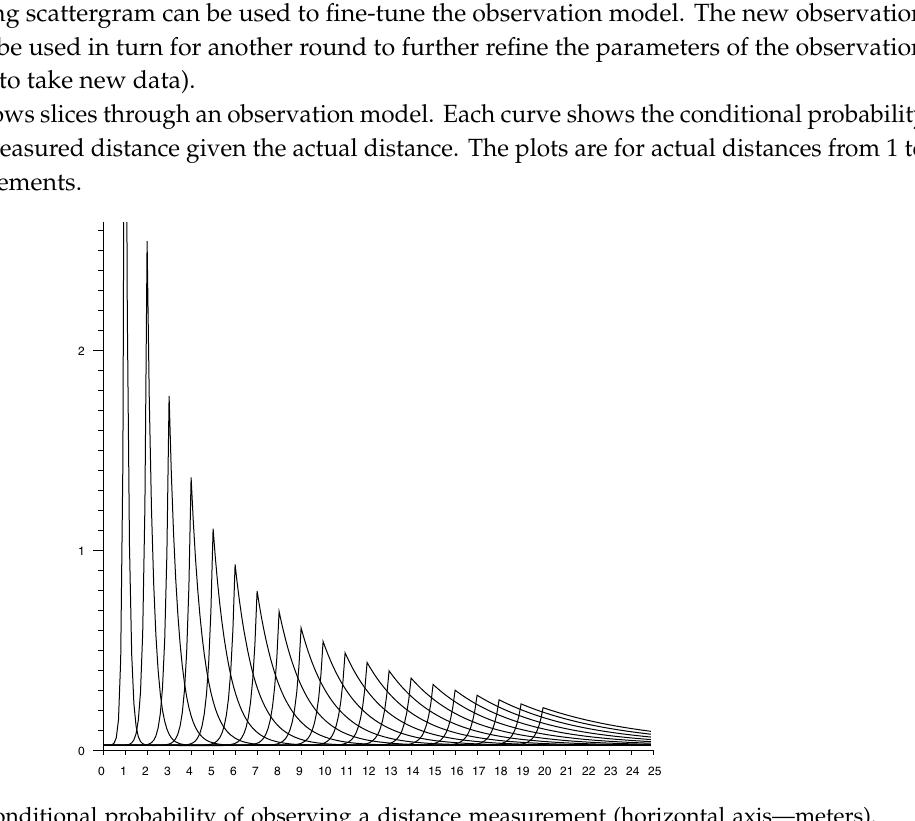
Figure 7. Conditional probability of observing a distance measurement (horizontal axis—meters). Each curve corresponds to a different value for the actual distance. Curves shown for actual distance of 1 m, 2 m, . . ., 20